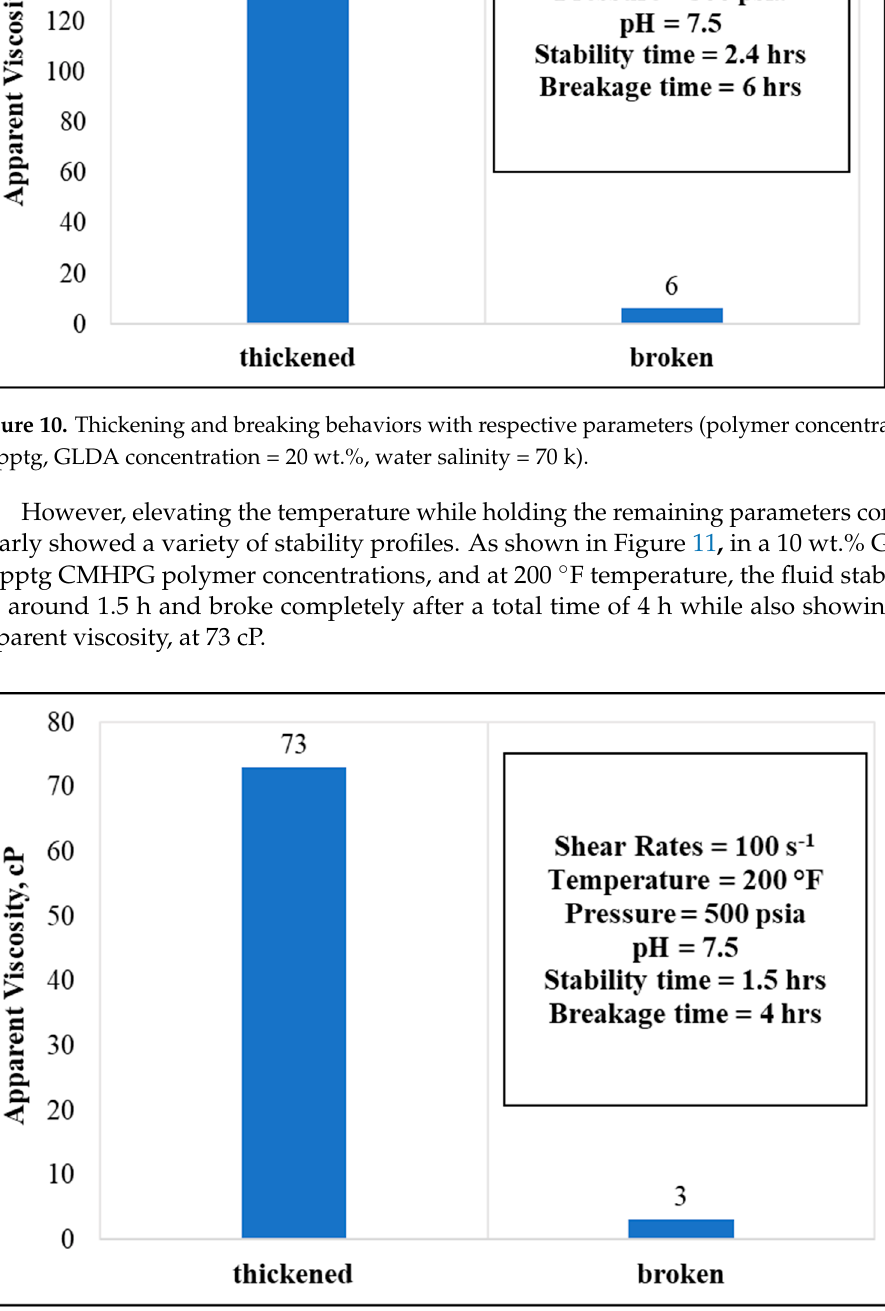
Figure 11. Thickening and breaking behaviors with respective parameters (polymer concentration = 50 pptg, GLDA concentration = 10 wt.%, water salinity = 70 k). Finally, setting the experiment at the highest temperature (300 ◦ F) drastically changed the stability time window. In a 10 wt.% GLDA, 50 pptg CMHPG polymer